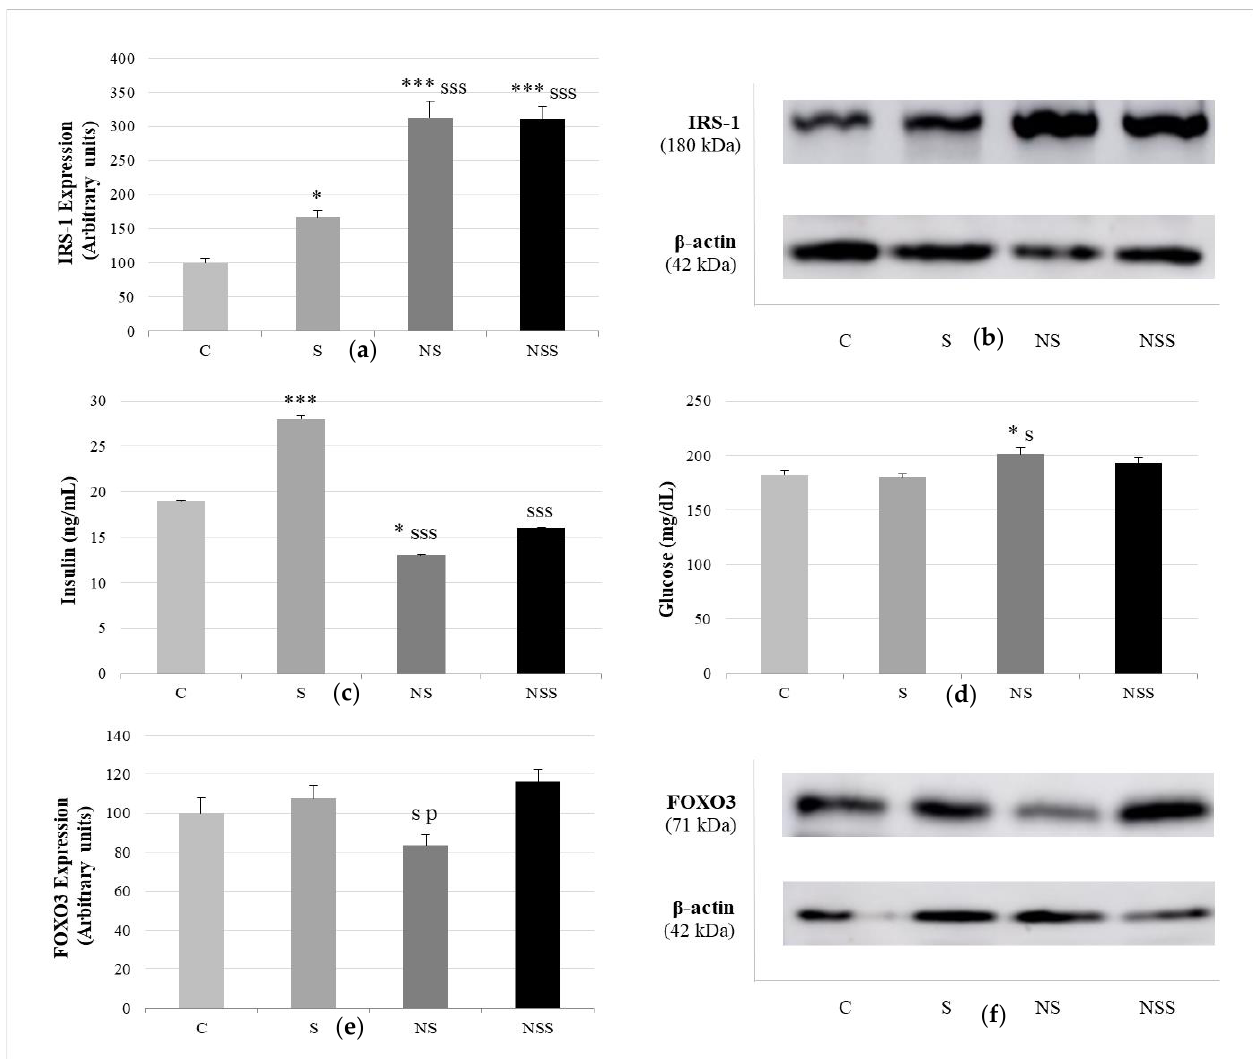
Figure 5. Pro-adipogenic pathways: insulin signaling and FOXO3a-autofaghy. Expression of IRS-1 (expressed as percent arbitrary relative units, referring to values in control animals, which were defined as 100%) ( a ). Representative Western blot for the expression of IRS-1 and β -actin (as load control) ( b ). Insulin levels ( c ). Glucose levels ( d ). Expression of FOXO3 (expressed as percent arbitrary relative units, referring to values in control animals, which were defined as 100%) ( e ). Representative Western blot for the expression of FOXO3 and β -actin (as load control) ( f ). The results were expressed as means ± SEMs and analyzed using a multifactorial one-way ANOVA followed by Tukey’s test. The number of animals in each group was 6. SEM: standard error of the mean. Groups: C, control group; S, low-selenite group; NS, low-selenite-nanoparticle group; NSS, moderate-selenite-nanoparticle group. Significance: vs. C, * p < 0.05, *** p < 0.001; vs. S, s p < 0.05, sss p < 0.001; vs. NP, p < 0.05.